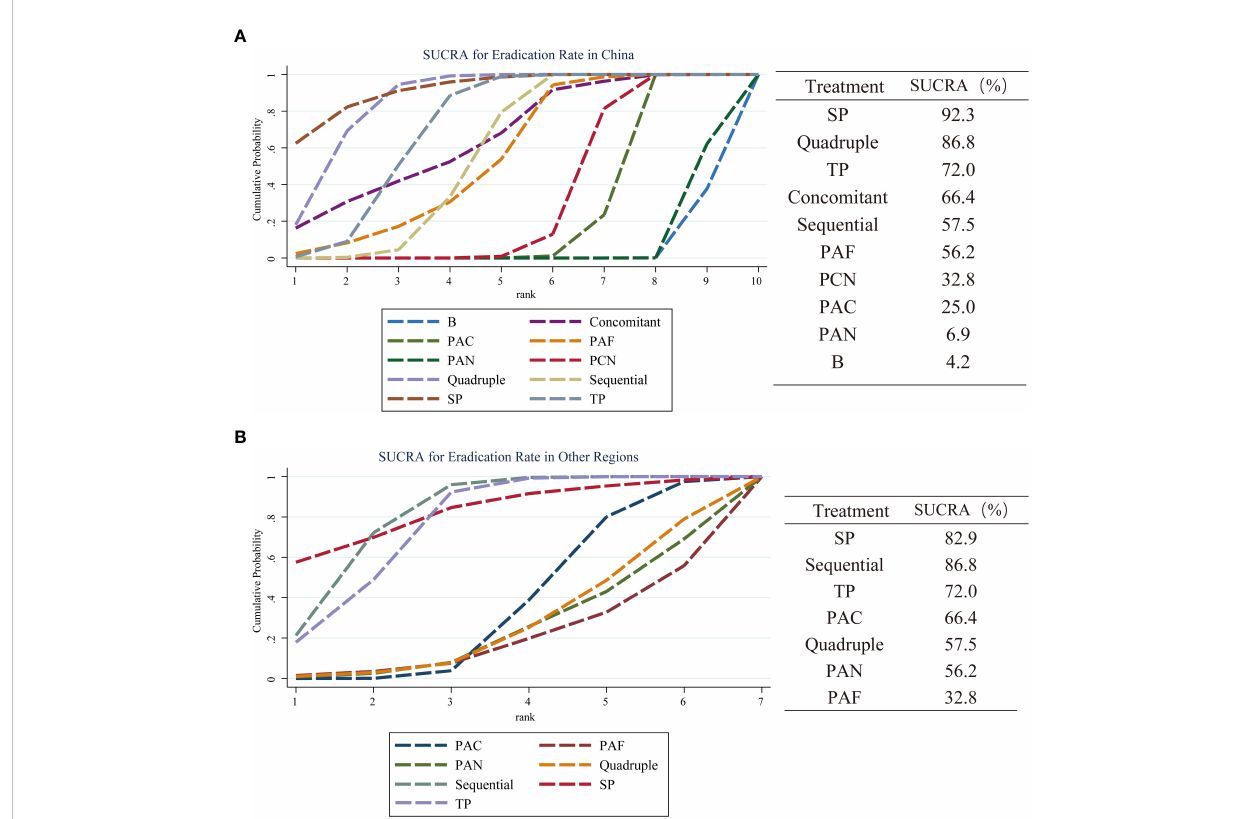
FIGURE 7 A subgroup analysis of the eradication rate of 10 treatment regimens in different regions. (A) SUCRA value of eradication rate and ranking of curative effect in China; (B) The performance of these results in other regions. Regimen labels: B, bismuth-containing triple therapy; Concomitant, concomitant therapy; PAC, PPI, amoxicillin and clindamycin; PAF, PPI, amoxicillin and furanes; PAN, PPI, amoxicillin and nitroimidazoles; PCN, PPI, clindamycin and nitroimidazoles; Quadruple, quadruple therapy; Sequential, sequential therapy; SP, sequential therapy with probiotics; TP, triple therapy with